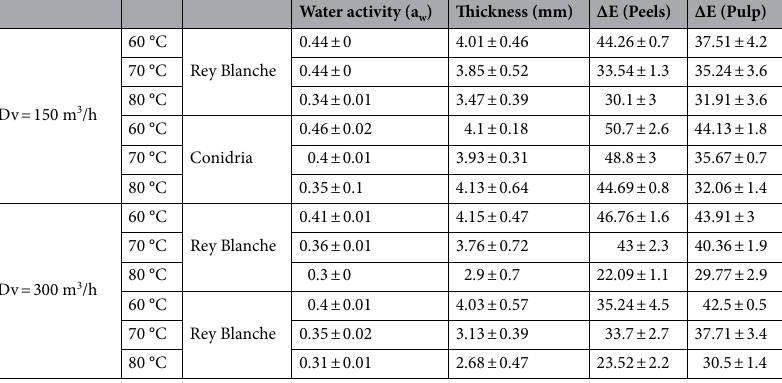
Table 3. Physical traits of dried fig slices as a function of temperature and drying air flow rate and temperature.